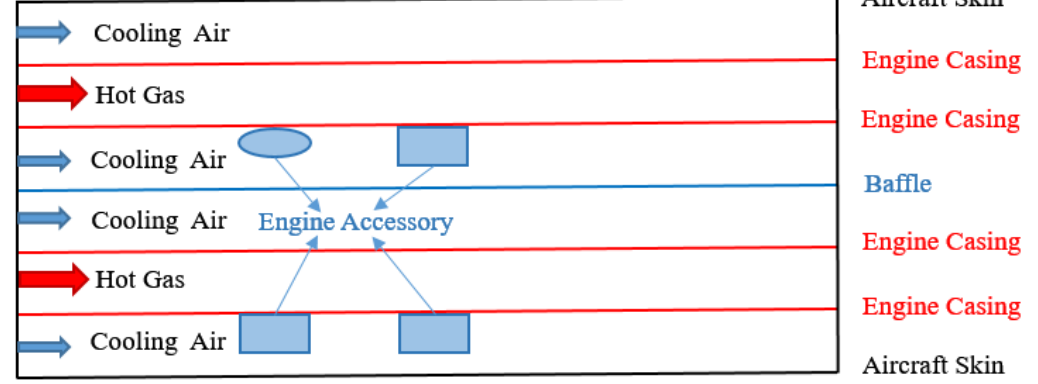
Figure 2. Schematic diagram along the radial direction of engine compartments.